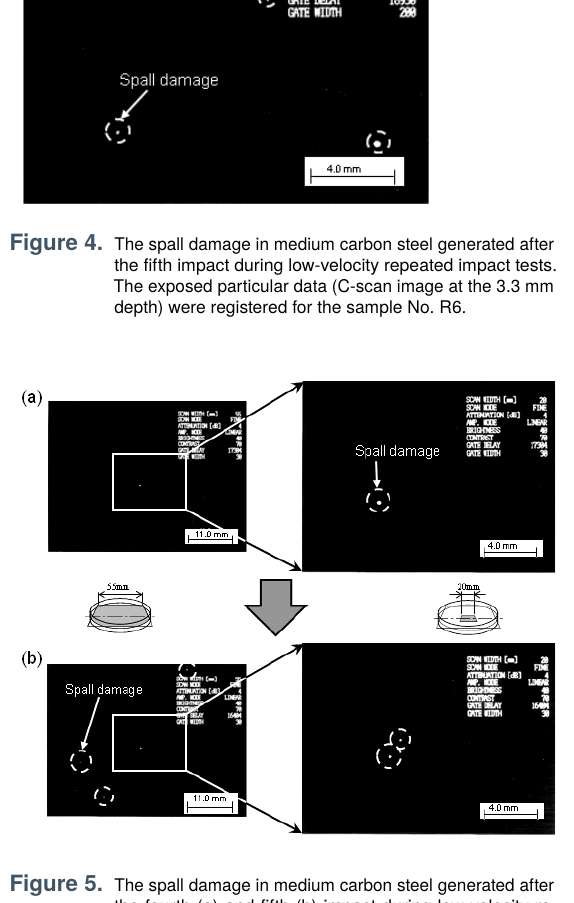
No. R6 where the white spots caused by reflected signal indicates the defects). Interestingly, in a single case the spall damage detected after the fourth impact developed during the subsequent fifth test (refer to Figure 5 –